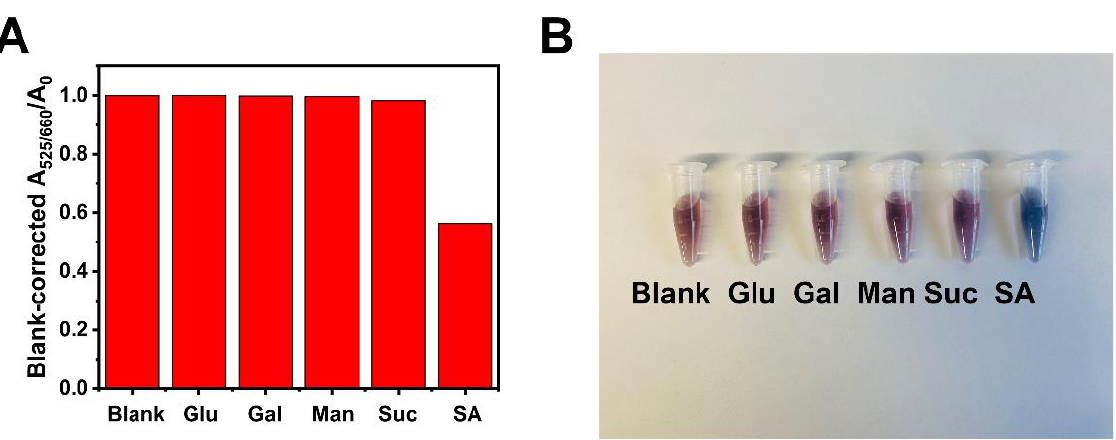
Figure 5. ( A ) Effects of different oligosaccharides, including the blank sample, 4 mM of glucose (Glu), galactose (Gal), mannose (Man), sucrose (Suc) and SA. ( B ) The graph shows the color change visible to the naked eye.